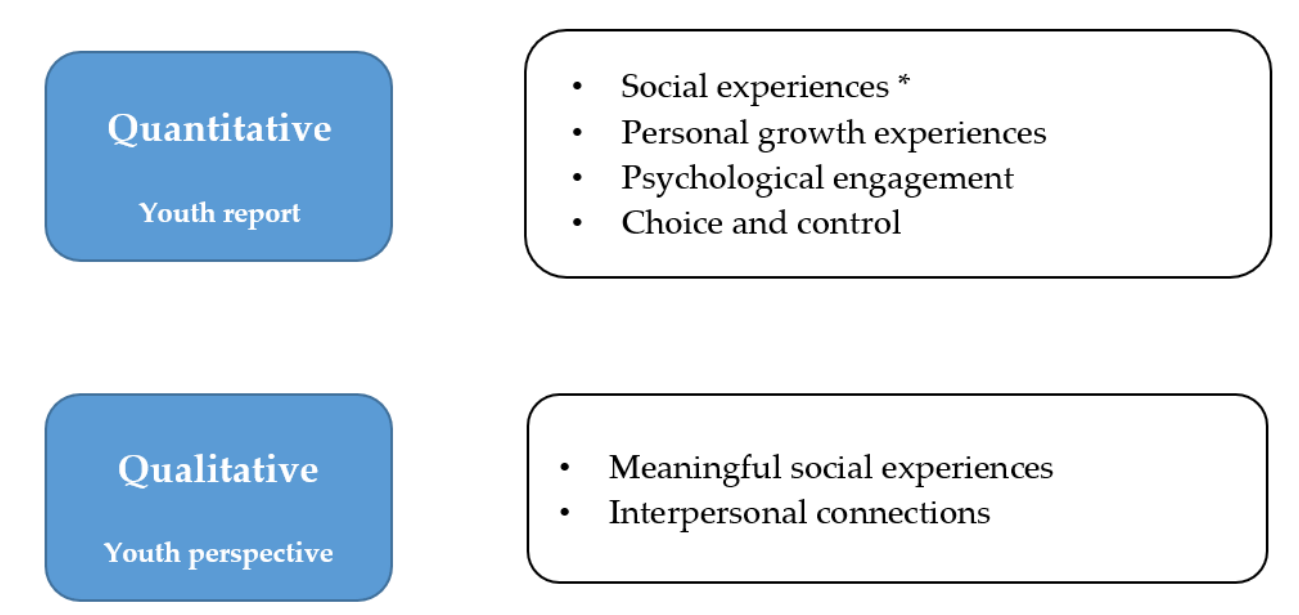
Figure 2. Evidence for Youth Experiences in RILS Programs. * A combination of two SEAS scales: social belonging and meaningful interactions. This figure refers to findings from several articles.